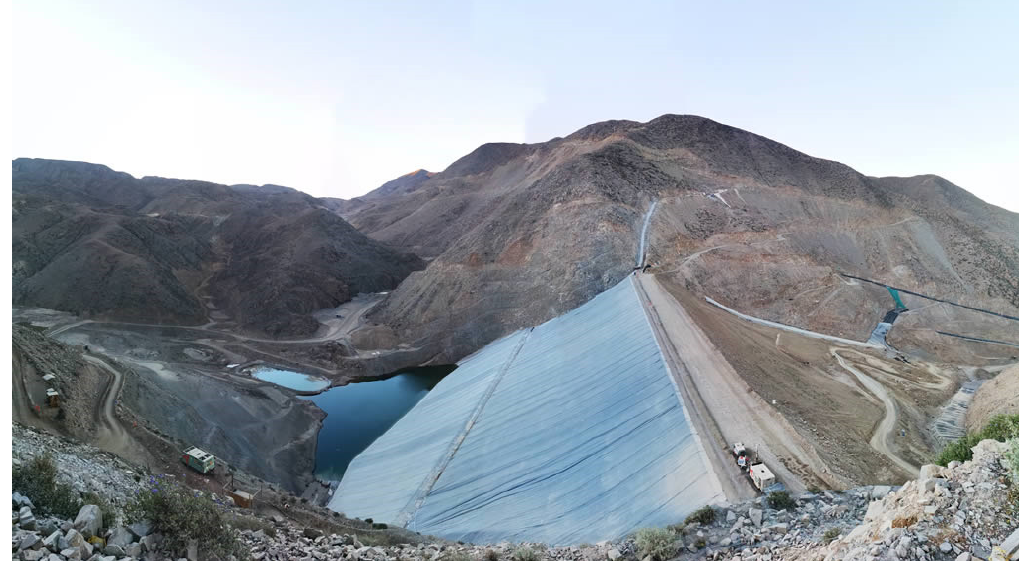
Figure 23. Panoramic view—mine waste rock dam upstream face waterproofing construction detail— TSF, Peru.